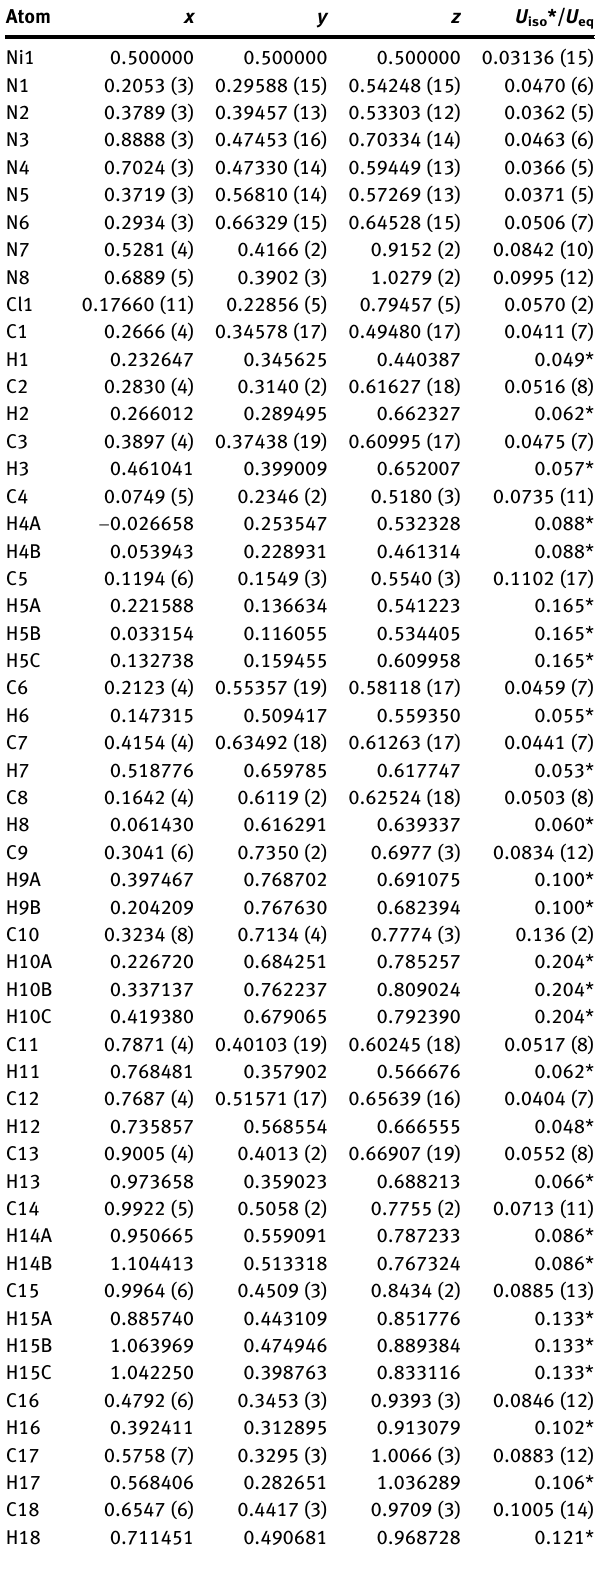
Table  : Fractional atomic coordinates and isotropic or equivalent isotropic displacement parameters (Å 